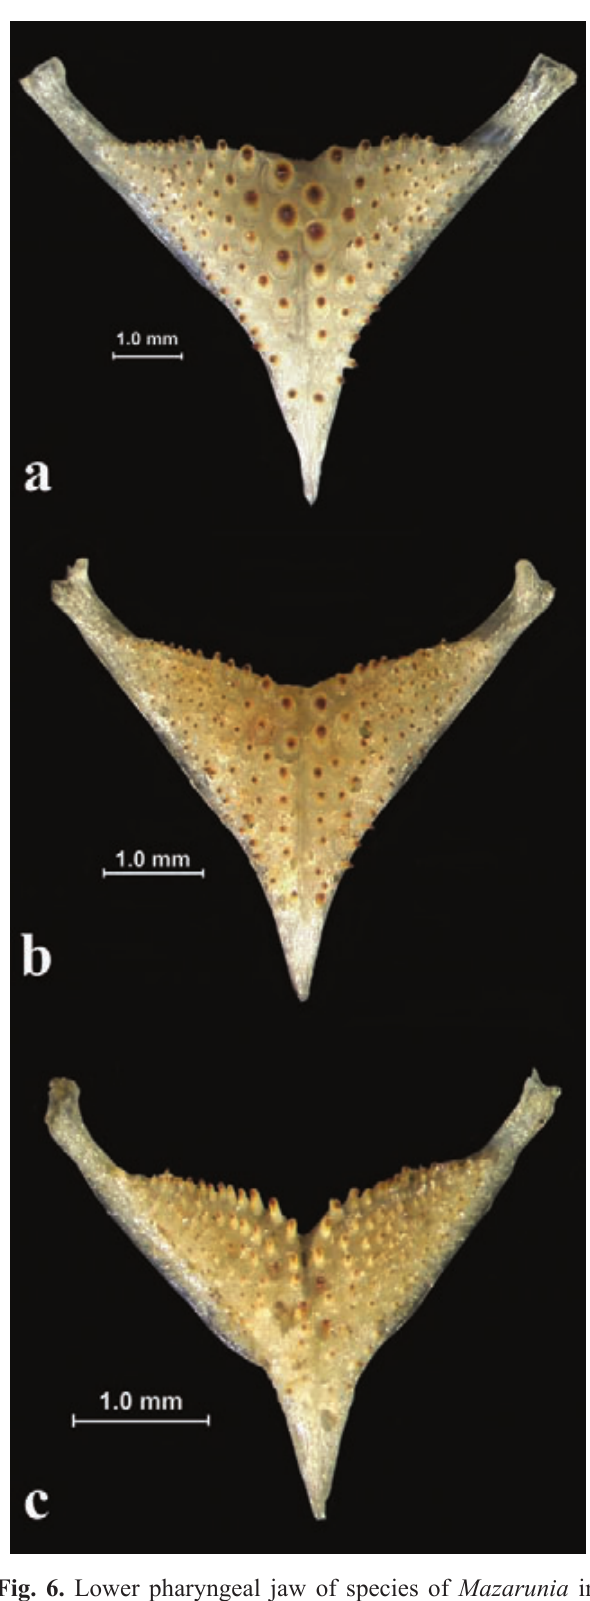
Fig. 6. Lower pharyngeal jaw of species of Mazarunia in occlusal view; a ) Mazarunia charadrica , paratype, ROM 89553, 67.1 mm SL, b ) Mazarunia mazarunii , ROM 83737, 58.5 mm SL, c ) Mazarunia pala , paratype, ROM 83753, 43.8 mm SL.